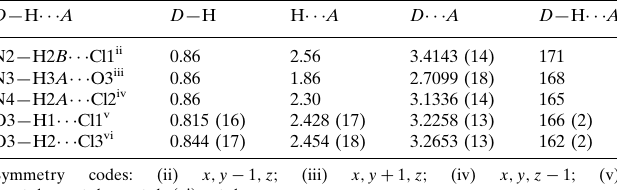
Hydrogen-bond geometry (A˚ , (cid:2)